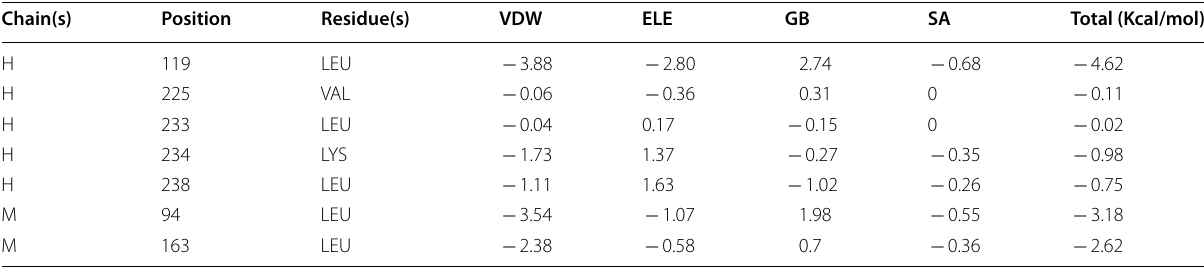
The output displays the mutated chains, residue positions, van der Waals potential, electrostatic potential, generalized born scores, solvent accessibility and the total binding energy score